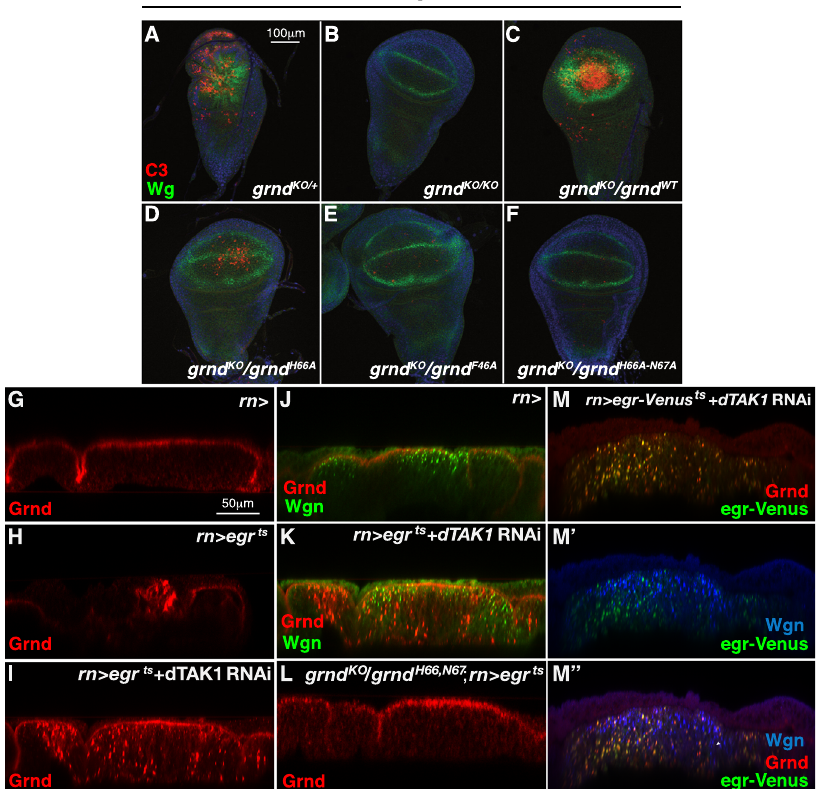
Fig. 4 Internalisation of Egr and Grnd in vesicles that are distinct from those labelled by Wgn precedes Egr-mediated apoptosis. A – F Drosophila wing imaginal discs of the indicated genotypes dissected from third instar larvae after 48 h of temperature-induced Egr expression, and stained for Wingless (Wg; green) and Caspase 3 (Cas3; red). G – L Transversal sections of wing discs of the indicated genotypes stained for Grnd (labelled in red) and Wgn ( J , K ; labelled in green). Egr mis-expression results in the internalisation of Grnd in intracellular vesicles that are distinct from those harbouring Wgn ( K ). M – M ″ Transversal sections of wing discs expressing Venus-tagged Egr stained for Grnd (labelled in red), Venus (labelled in green), and Wgn (blue) shows co- localisation of Grnd and Egr-Venus in intracellular vesicles that are distinct from Wgn-positive vesicles. Results of experiments presented in panels ( A – M ) were con fi rmed by successful replicate